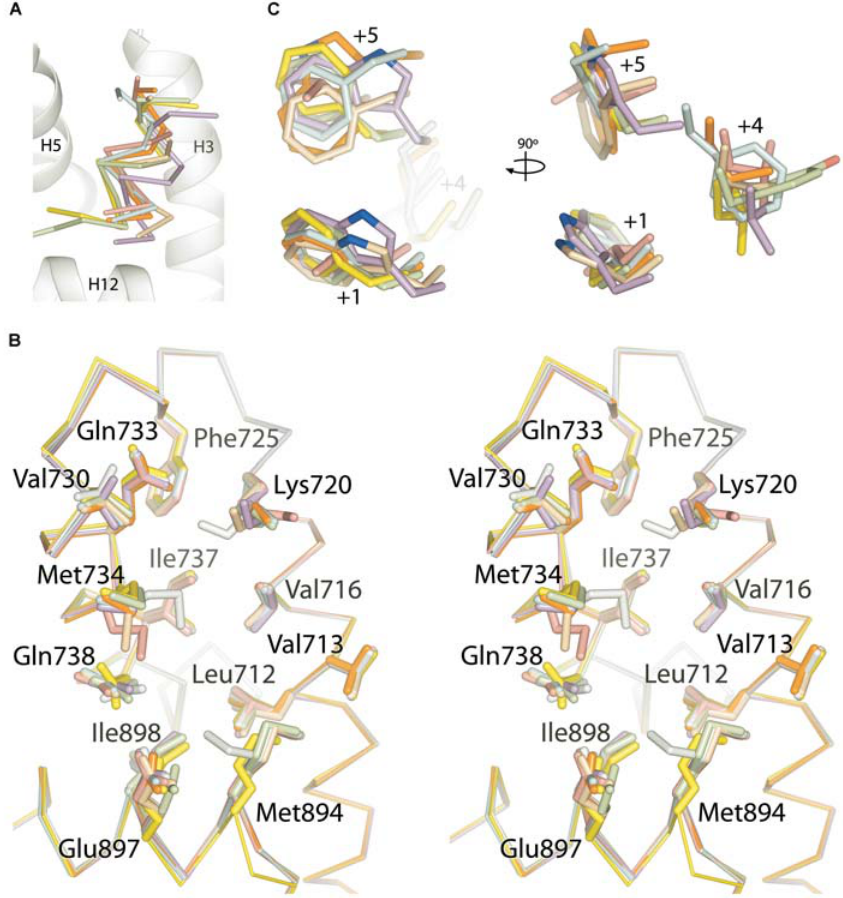
Figure 2. A Structural Profile of the AR Coactivator Binding Interface AR–peptide complexes are colored as follows: FxxLF, yellow; FxxLW, orange; WxxLF, wheat; WxxVW, purple; FxxYF, green; FxxFF, blue; LxxLL, pink; un- bound, grey. (A) C a trace of the peptides super- imposed onto the AF-2. For clarity only the LBD of AR–FxxLF is shown. (B) Superposition of the LBD of the AR– peptide complexes in the region of the coactivator interface. Backbone atoms are shown as a C a trace. Side chains of residues composing the interface are shown as sticks. (C) Hydrophobic side chains of the core motif superimposed as in